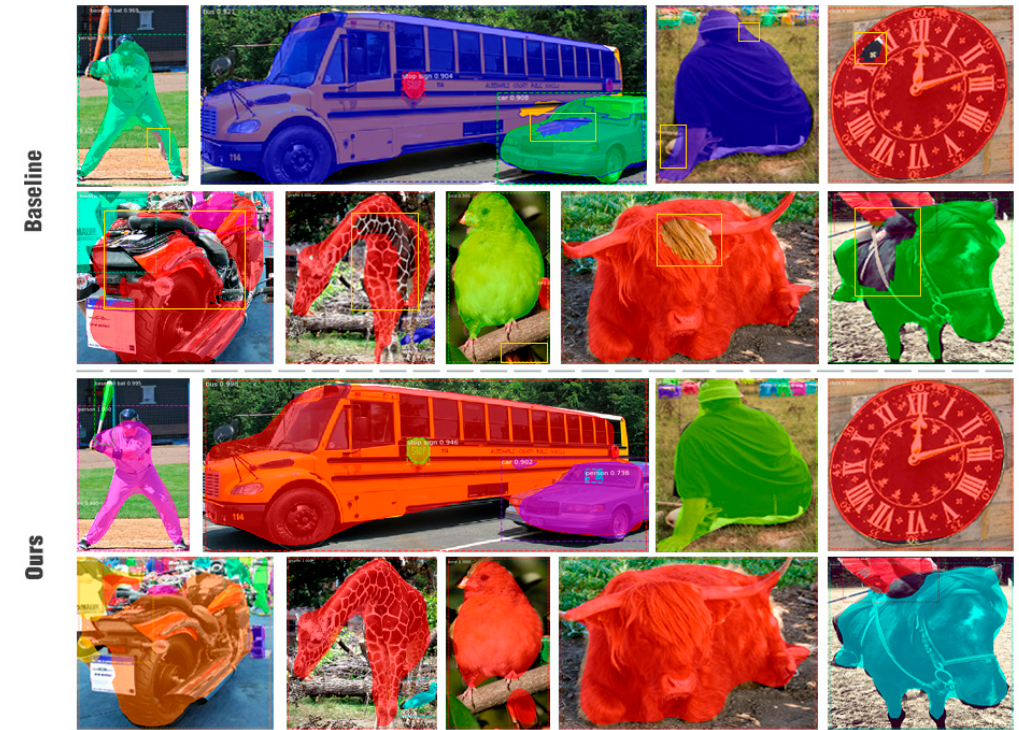
Figure 1. Mask R-CNN (mask region-convolutional neural network) baseline (top) vs. MR R-CNN (Mask-Refined R-CNN, bottom). The sample images are all screenshots of proposals. Our work can better segment large instances.